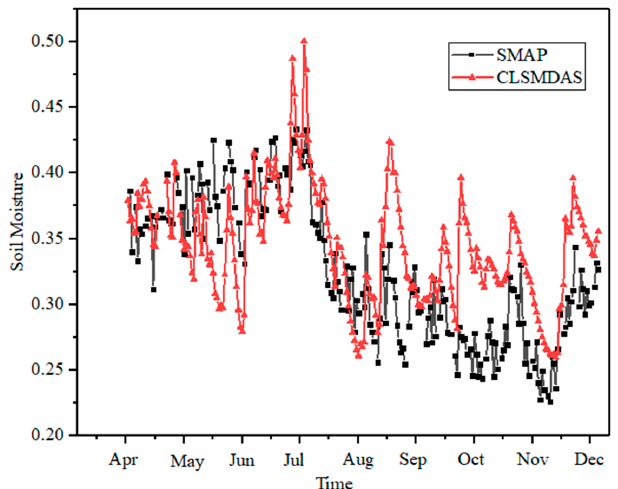
Figure 3. Regional comparison between SMAP soil moisture and CLSMDAS soil moisture.